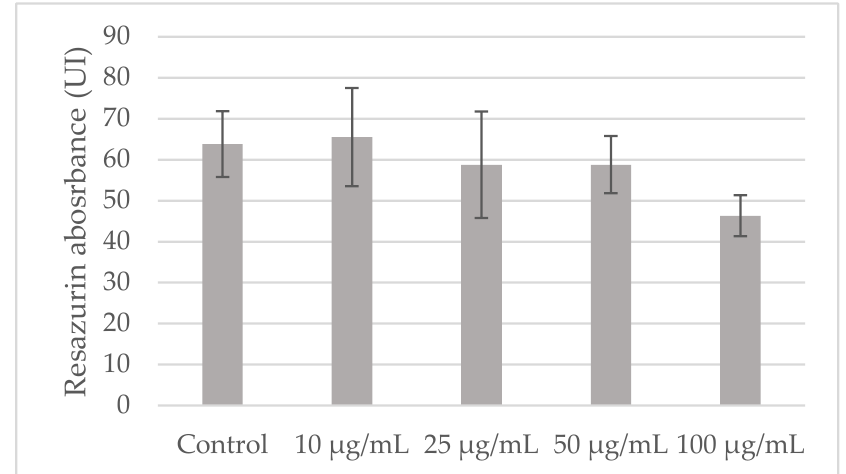
Figure A2. Viability of PBMCs in presence of LS-E (50 µg/mL, 24 h incubation).